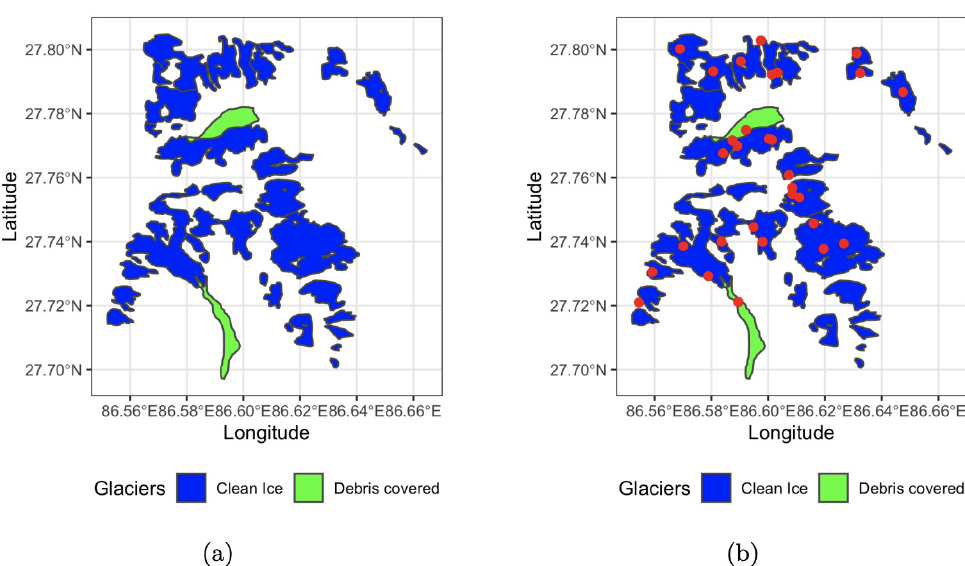
Figure 2. ( a ) Raw glacier boundaries. ( b ) Glacier boundaries with sampled patches. In raw data, target glaciers only make up a limited fraction of area in the whole data. We sample patches from areas with glaciers, and the center of the sampled patches are marked as red